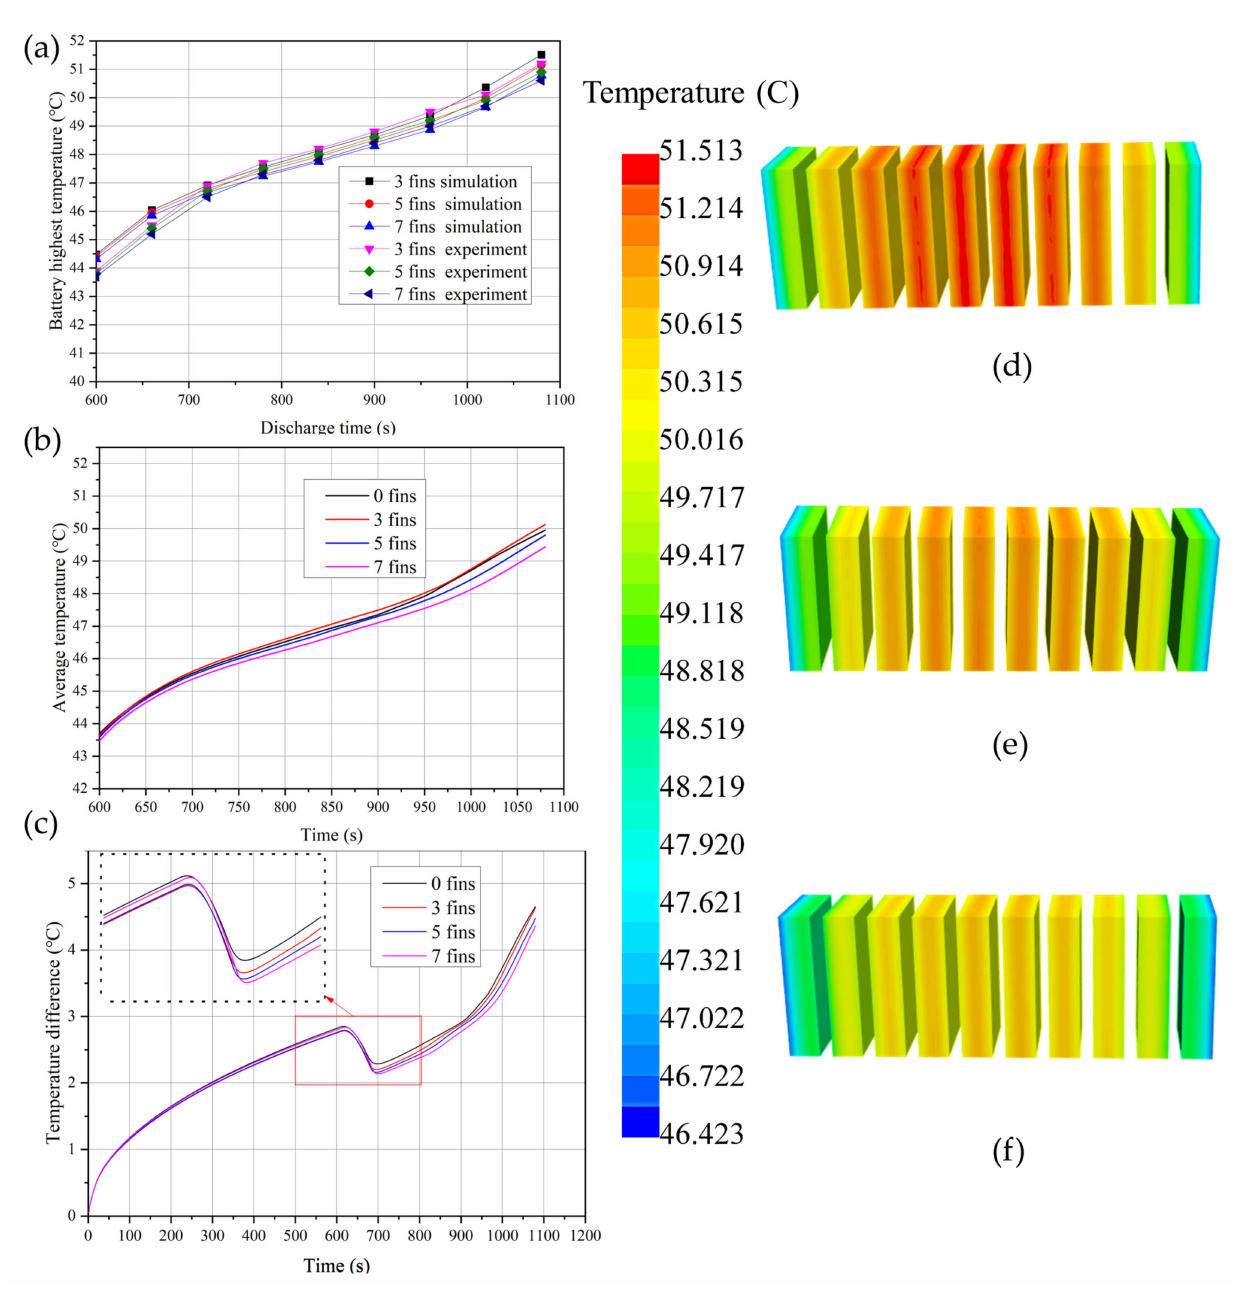
Figure 8. Temperature curve of battery pack with a different number of fins and temperature field of a battery pack with PCM containers which have different quantities of fins. ( a ) maximum temperature; ( b ) average temperature; ( c ) temperature difference ( d ) 3-fin PCM container; ( e ) 5-fin PCM container; ( f ) 7-fin PCM